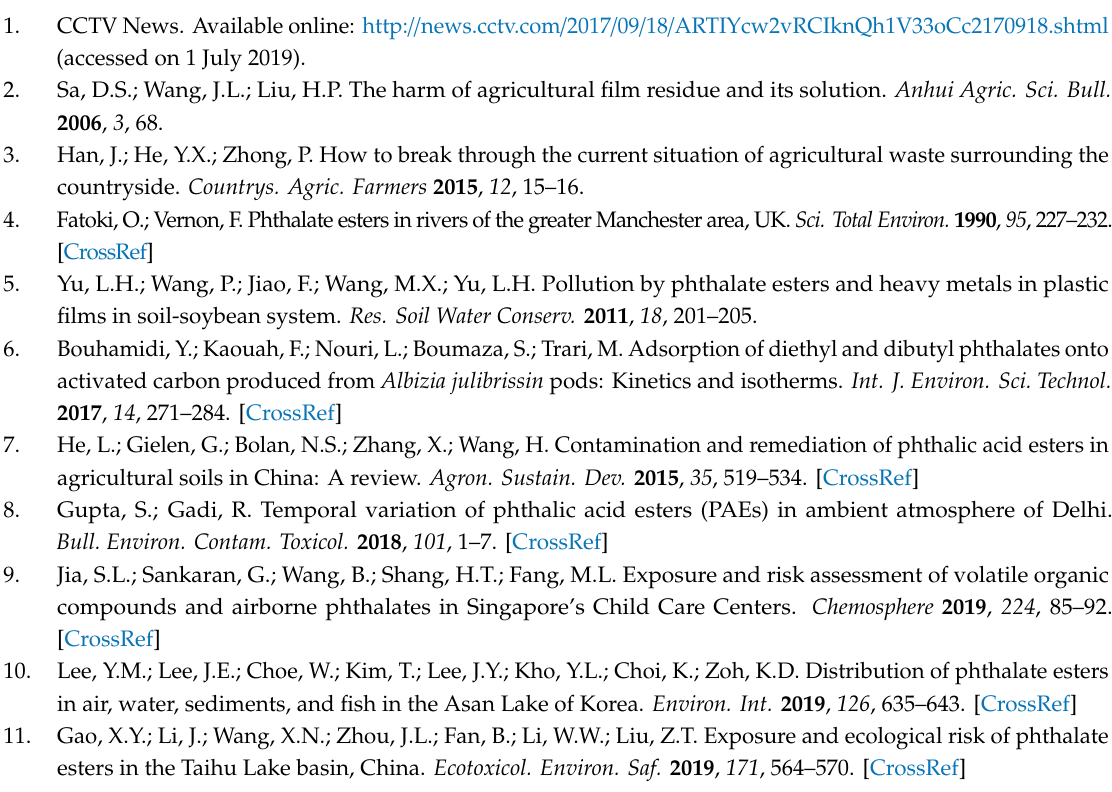
Figure S1: The composition patterns of PAEs in samples collected from (a) Zilingpu ( n = 52 = 14 fruit sample + 14 leaf sample + 14 soil sample). Cucumber-y1, the first sampling greenhouse planted cucumber (yellow) / yellow cucumber; Tomato-g1, the first sampling greenhouse planted tomato (green) / green tomato; Chili-g1, the first sampling greenhouse planted chili (green) / green chili; Pumpkin-r1, the first sampling greenhouse planted pumpkin (red chestnut) / red chestnut pumpkin. (b) Zhanghe ( n = 36 = 12 fruit sample + 12 leaf sample + 12 soil sample). Eggplant-p1, the first sampling greenhouse planted eggplant (purple long) / purple long eggplant; Chili-H1, the first sampling greenhouse planted chili (Hangzhou) / Hangzhou chili; Cauliflower-1, the first sampling greenhouse planted cauliflower. (c) Pengdun ( n = 52 = 14 fruit sample + 14 leaf sample + 14 soil sample). Tomato-1, the first sampling greenhouse planted tomato; Cucumber-m1, the first sampling greenhouse planted cucumber (mini) / mini-cucumber; Eggplant-1, the first sampling greenhouse planted eggplant; Chili-s1, the first sampling greenhouse planted chili (screw) / screw chili. Histogram heights < 3% are hidden, Table S1: Overview usage information on plastic membranes and production mode at the three study areas, Table S2: Physicochemical properties of soils at the three study areas, Table S3: PAE concentrations in samples collected from Zilingpu ( µ g kg − 1 dry weight, DW), Table S4: PAE concentrations in samples collected from Zhanghe ( µ g kg − 1 DW), Table S5: PAE concentrations in samples collected from Pengdun ( µ g kg − 1 DW), Table S6: Eigenvalues and contribution rates of PCA, Table S7: Eigenvectors of principal component analysis in Figure 3a, Table S8: Eigenvectors of principal component analysis in Figure 3b, Table S9: Pearson correlation analysis of PAEs in di ff erent samples. Author Contributions: Conceptualization, T.M. and W.Z.; data curation, T.M.; formal analysis, T.M.;